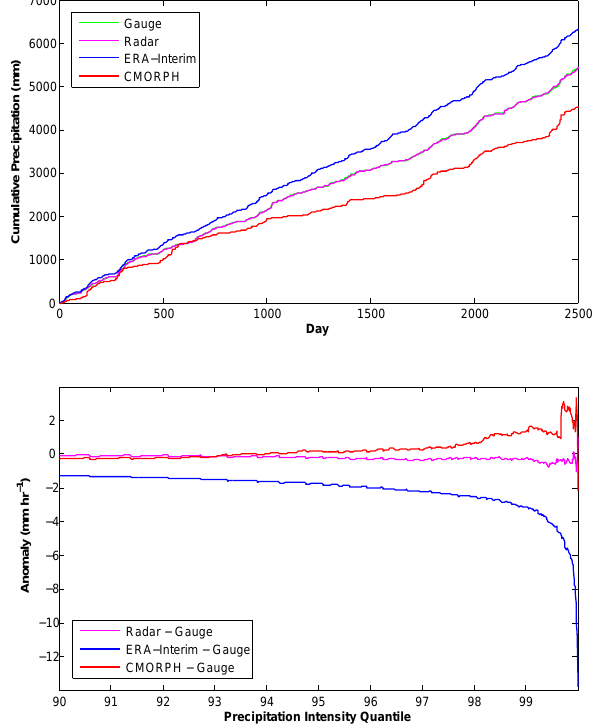
Figure 6. Top plot ( a ) shows cumulative precipitation for each source. Bottom plot ( b ) shows anomalies in > 90th-quantile pre- cipitation intensities between gauge and other sources.